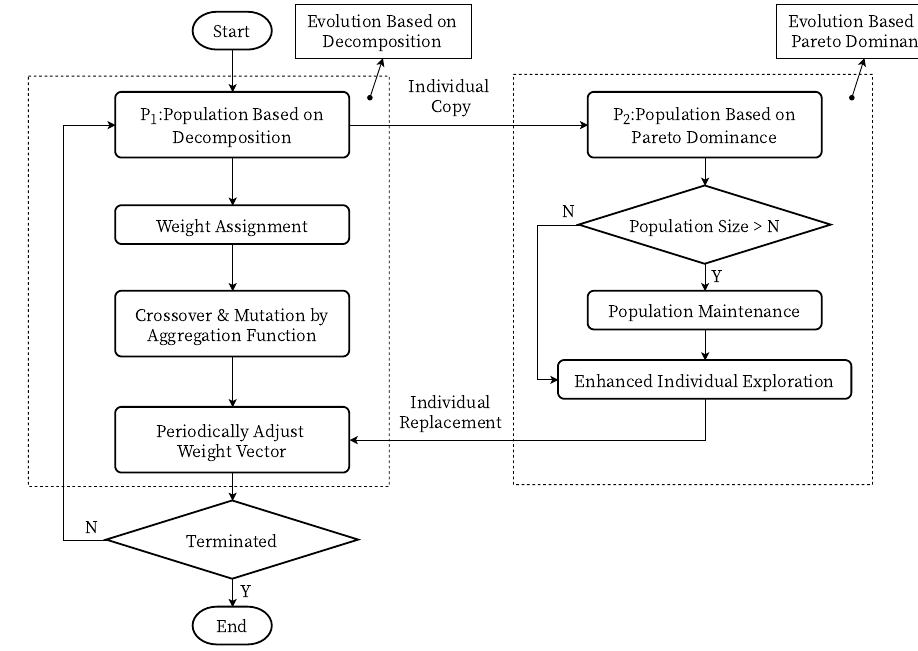
Figure 2. Framework of the Proposed Algorithm